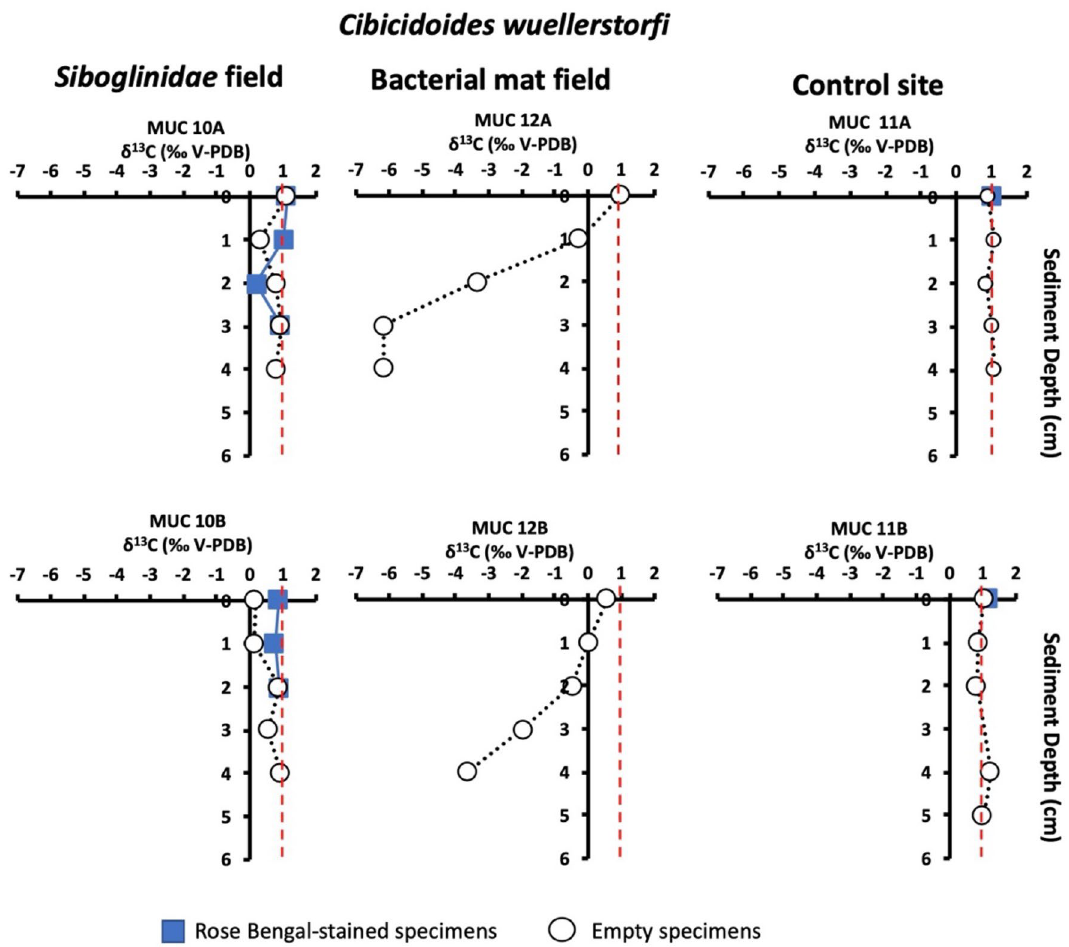
Figure 5. Carbon isotope values (δ 13 C) of Cibicidoides wuellerstorfi from the Siboglinidae field (MUC 10 and MUC 10B), bacterial mat field (MUC 12A and MUC 12B), and control site (MUC 11A and MUC 11B). The vertical red line indicates the δ 13 C minimum value for non-seep conditions 34